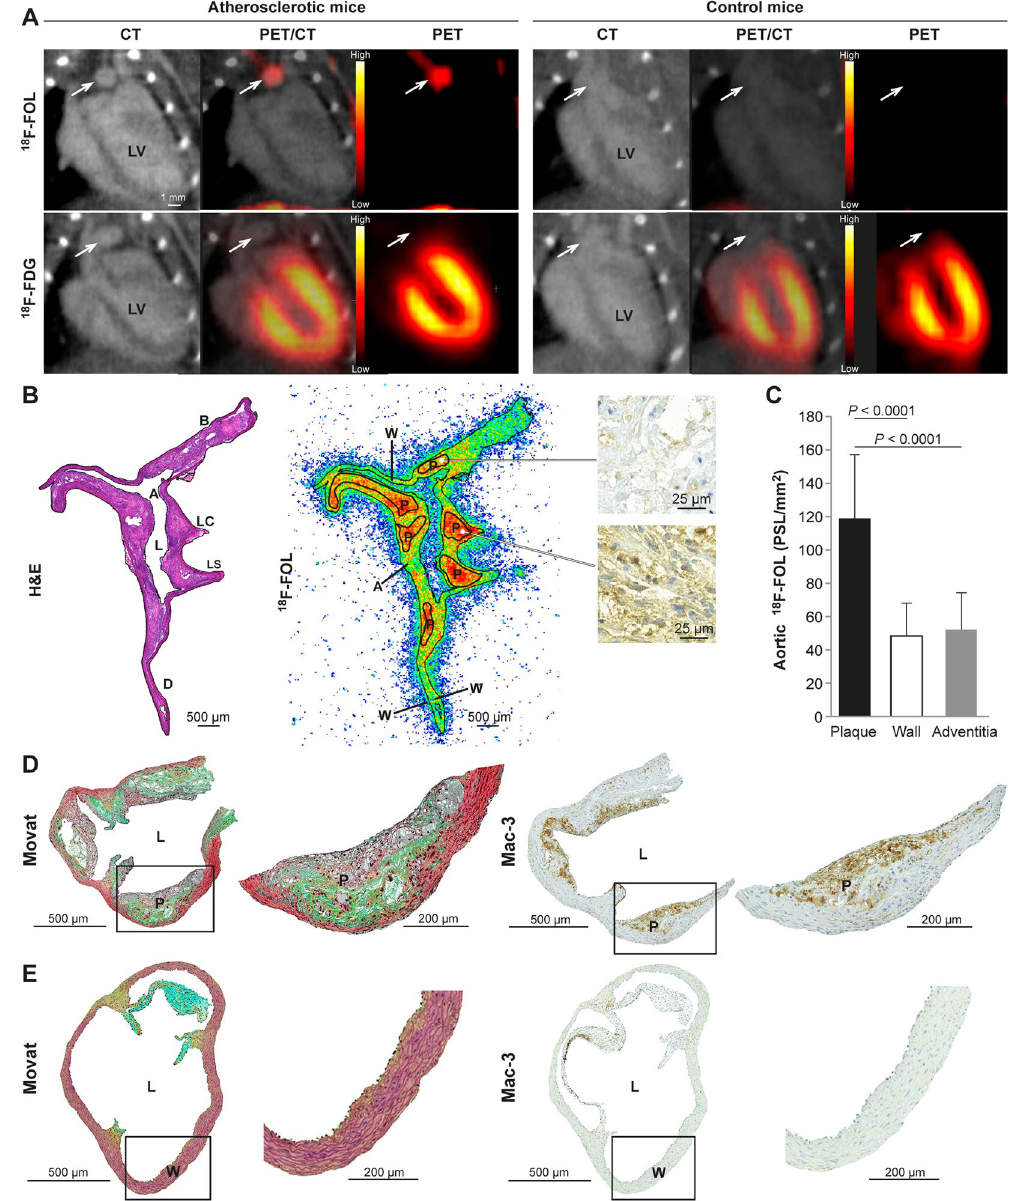
Figure 3. Overview of the mouse studies. ( A ) Representative coronal views of in vivo 18 F-FOL and 18 F-FDG PET/CT images (60–90 min post-injection) of atherosclerotic LDLR − / − ApoB 100/100 and healthy C57BL/6N control mice. White arrows denote the aortic arch. LV = left ventricle. PET images are displayed in the same color scale. ( B ) Left: hematoxylin-eosin (H&E) staining of a longitudinally sectioned atherosclerotic mouse aorta. A = arch; AA = ascending aorta; B = brachiocephalic artery; D = descending thoracic aorta; L = lumen; LC = left common carotid artery; LS = left subclavian artery. Middle: superimposed 18 F-FOL ex vivo autoradiograph and H&E staining, with black lines representing the tissue contour and regions of interest. P = plaques (excluding media); W = healthy vessel wall (no lesion formation); A = adventitia (mainly adipose tissue around the aorta). Right: Mac-3 immunohistochemical staining corresponding to a plaque with low (top) or high (bottom) 18 F- FOL uptake. ( C ) Quantification of 18 F-FOL binding on the ex vivo autoradiography of atherosclerotic mice aorta ( n = 8). P value, one-way ANOVA with Tukey’s correction. PSL/mm 2 = photostimulated luminescence per mm 2 normalized for injected radioactivity dose. Error bars denote standard deviation. ( D ) The aortas of LDLR − / − ApoB 100/100 mice contained atherosclerotic plaques that were mostly of the fibroatheroma-type with a well-defined fibrous cap whereas ( E ) the aortas of healthy C57BL/6N control mice showed no signs of atherosclerosis. Representative formalin-fixed, paraffin-embedded aortic root sections were stained with Movat’s pentachrome (black = nuclei; yellow = collagen, reticular fibers; blue = ground substance, mucin; bright red = fibrin; red = muscle) or with anti-mouse Mac-3 immunohistochemistry (brown color). The high-power views are of the area within the black rectangle on the left images. Mac-3 positive cells (macrophages) appear brown in color. L = lumen; P = plaque; W = healthy vessel